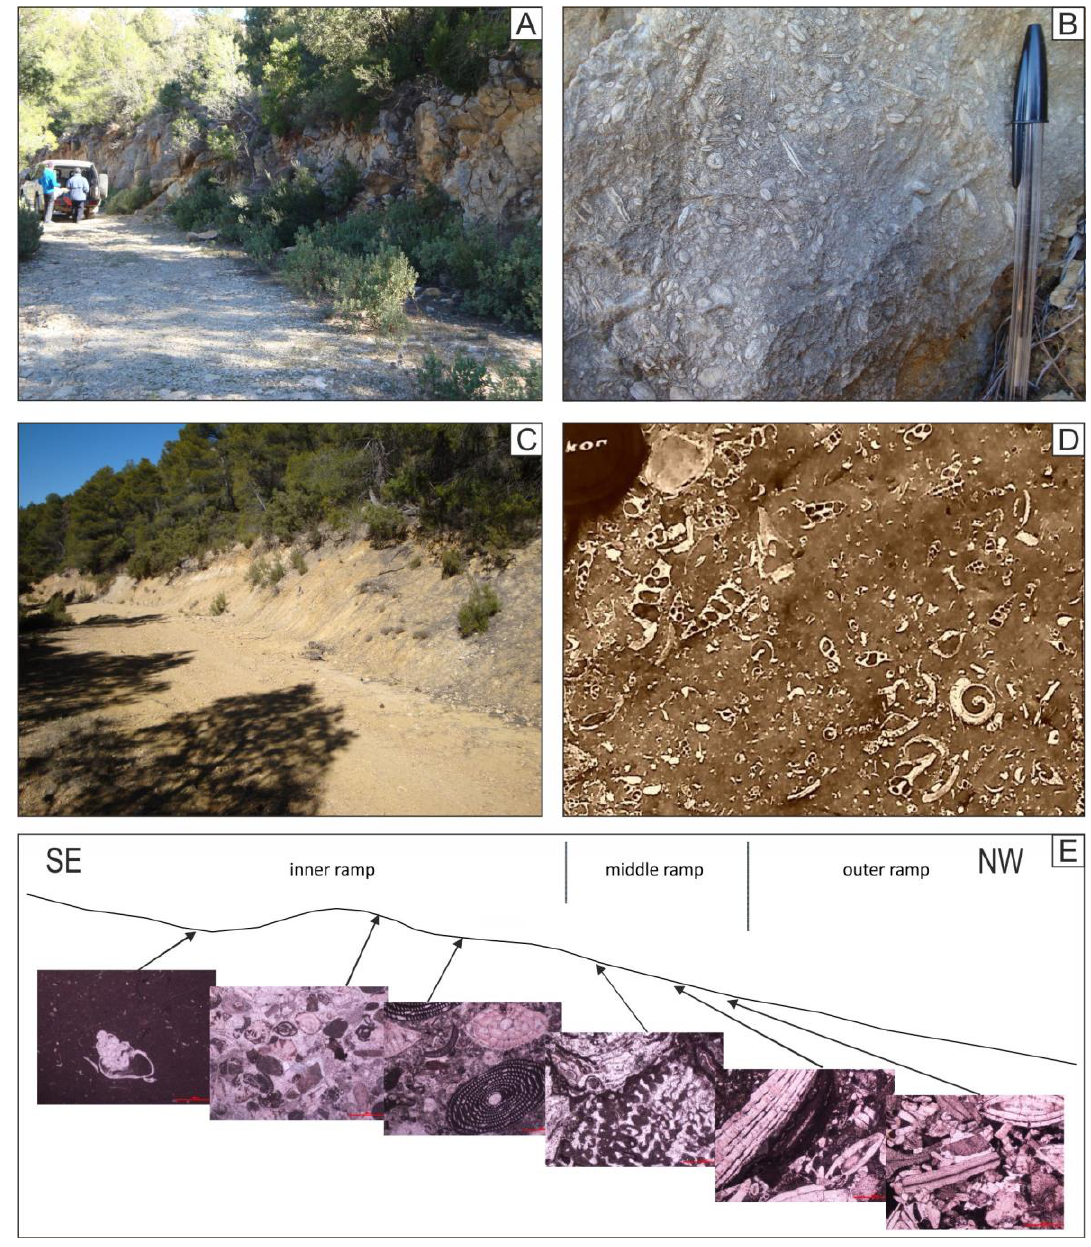
Figure 7. Site 3: The Lower Eocene Espuña and Valdelaparra fms in the Malvariche Valley. ( A ) Field outcrop of the Espuña Fm; ( B ) Detail of the fossils from the Espuña Fm. ( C ) Field outcrop of the Valdelaparra Fm. ( D ) Detail of the fossils from the Valdelaparra Fm. ( E ) Interpretative paleoecological model of the Espuña-Valdelaparra Fms (modified from [1]).